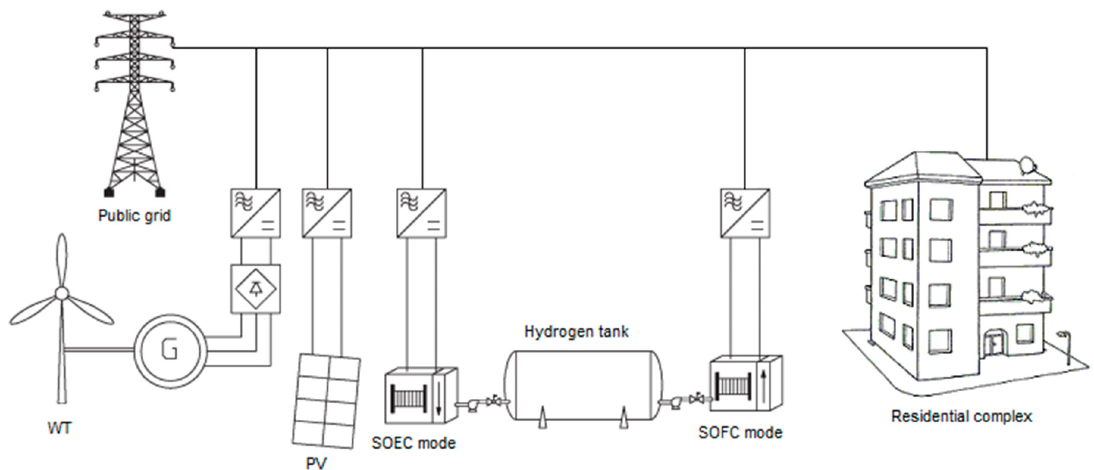
Figure 1. Simplified plant schematic, adapted from [23], including the reversible solid oxide (rSOC)-based renewable microgrid, connection to the public grid and served residential complex. It is worth remarking here that all acronyms appearing in the above figure are explained in the nomenclature section at the end of the paper.